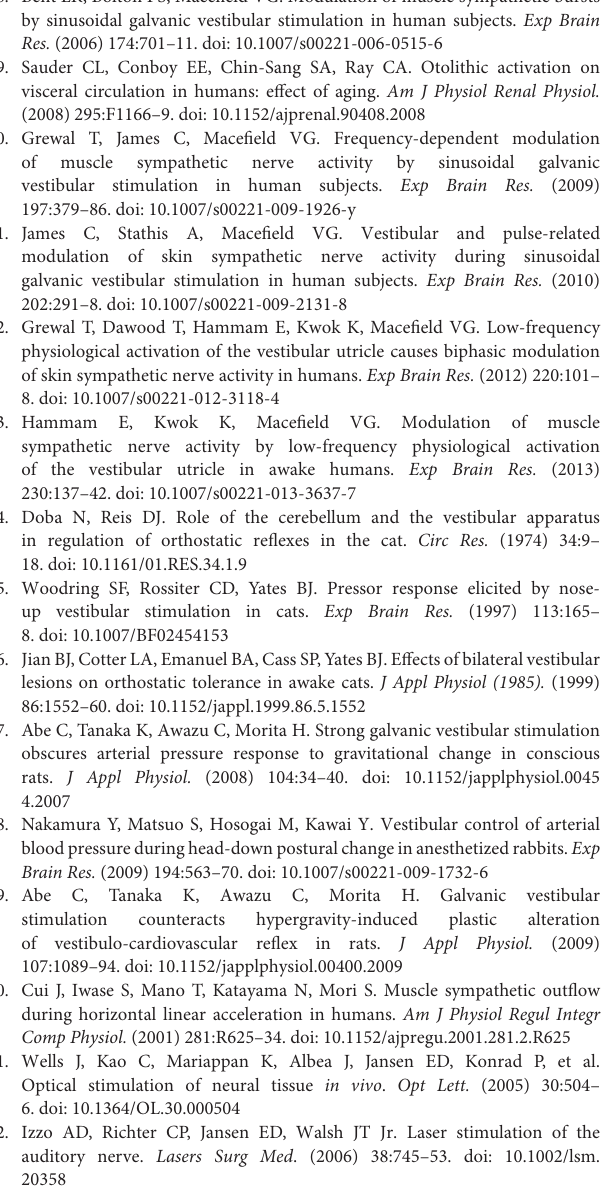
Supplementary Figure 2 | Magnitude of IR evoked changes in AC. The magnitude of changes in MBP (top) and HR (bottom) for 13 stimulation periods across four rats during the initial cycle of AC stimulation with IR are shown. (A,B) Show the responses to IR applied at varying radiant energies (377–512 µ J/pulse) when compared to the averaged baseline MBP (mmHg) ( R 2 = 0.078) and HR (bpm) ( R 2 = 0.083). (C,D) Show weak correlation between stimulation